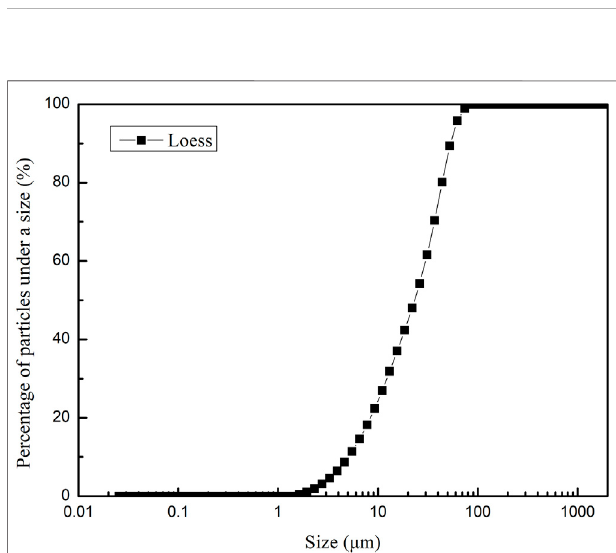
FIGURE 1 | Particle size distribution of selected loess.